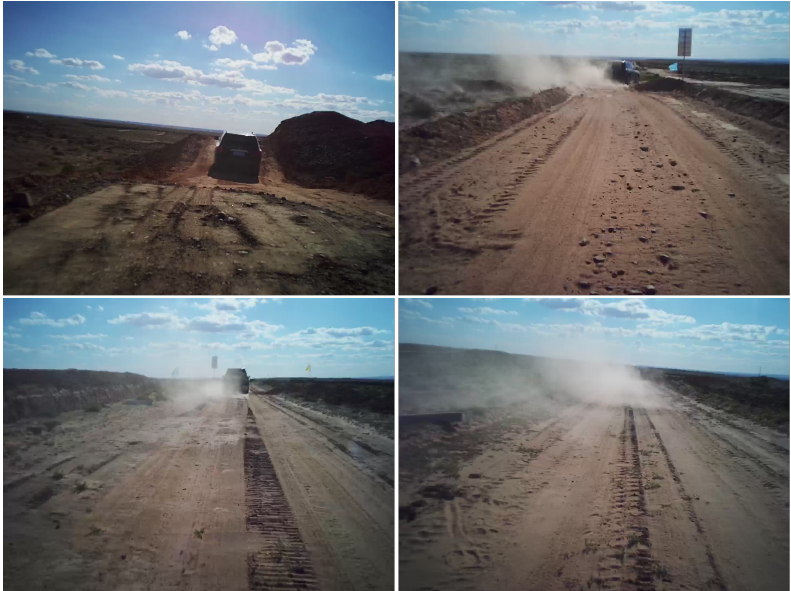
Figure 1. The experimental